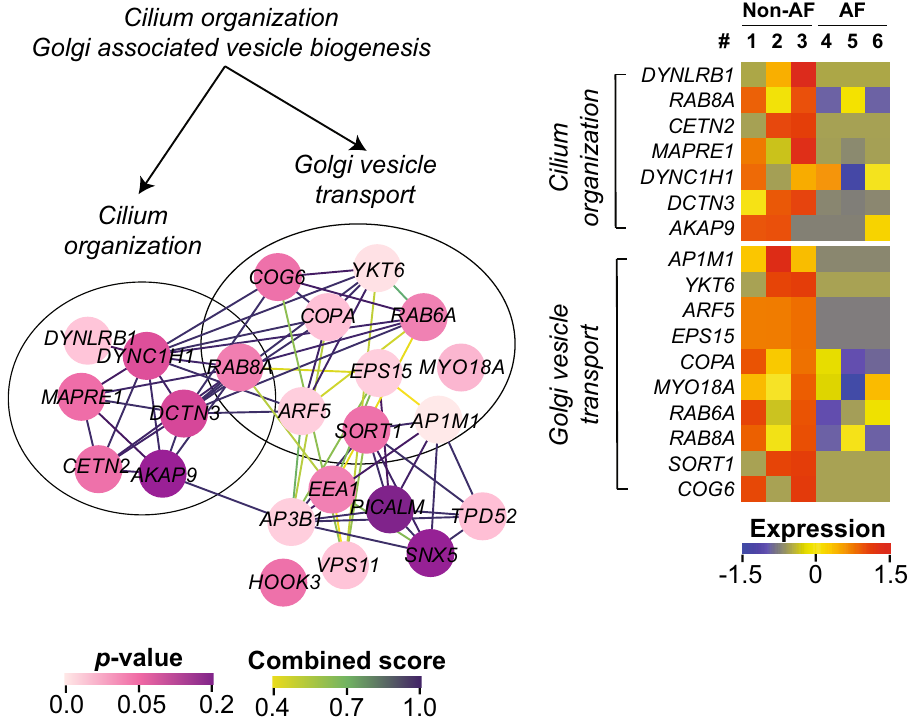
Figure 4. The PPI of the leading edge in the down-regulated gene-sets in AF. The PPI of the leading edge and the expression profile that were derived from Cilium organization and Golgi associated vesicle biogenesis. Only the proteins with non-adjusted p -value < 0.2 are displayed here. The color of the nodes and the edges corresponds to the non-adjusted p -value (0–0.2) and the STRING combined score (0.4–1), respectively. The color scale of expression represents the z-score of normalized spectral counts of each protein (shown as its gene name in each heatmap). The heatmaps were generated using R software 54 (version